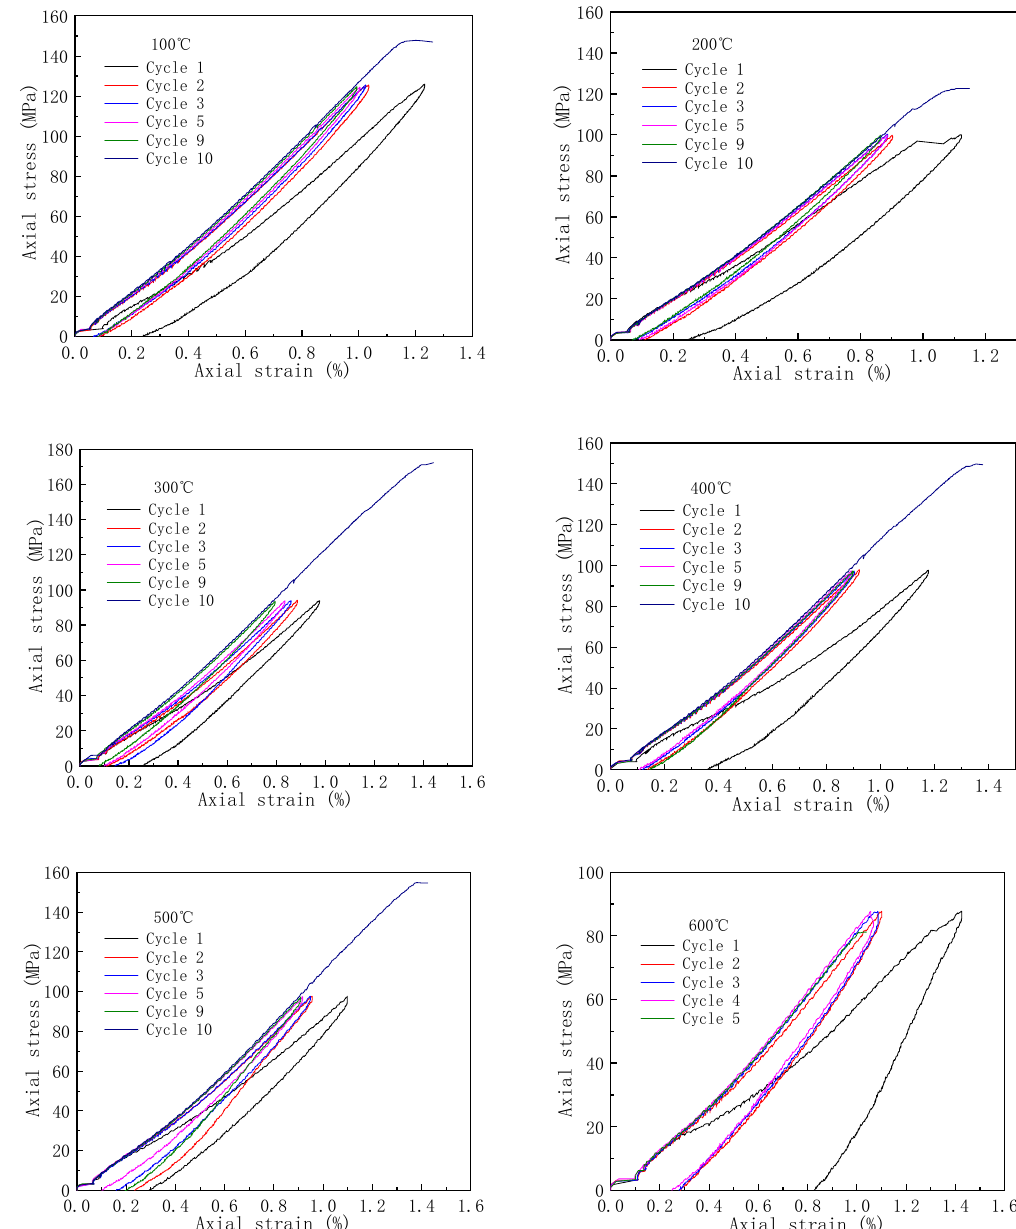
Figure 4. Stress–strain curves of granite sample when the upper limit of cyclic stress is 85% of UCS at six upper limit cyclic temperatures.